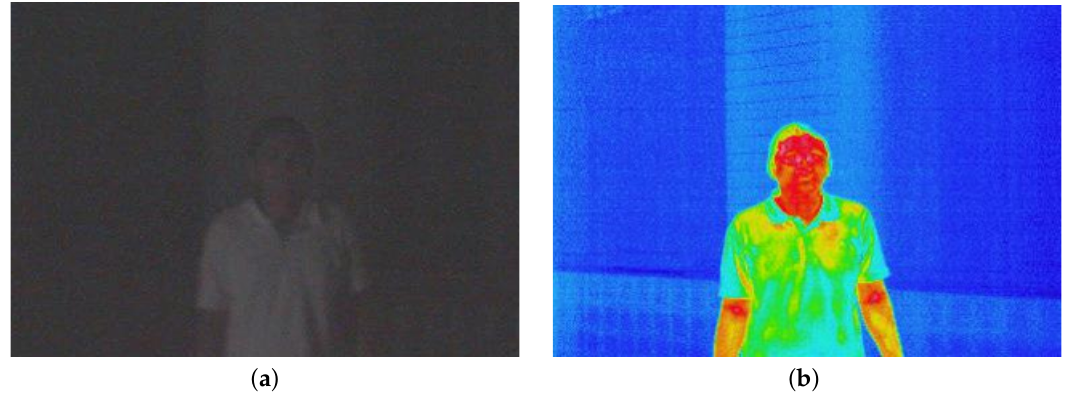
Figure 1. Image examples in different spectra: ( a ) in the visible spectrum; ( b ) in the thermal infrared